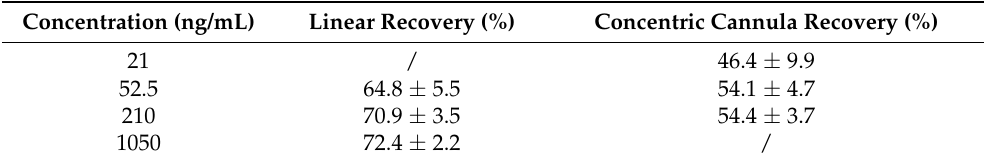
Table 2. Results of triptolide concentrations on in vivo recovery determined by the loss method from the linear microdialysis probe and concentric cannula microdialysis probe ( n = 5). Concentration (ng/mL) Linear Recovery